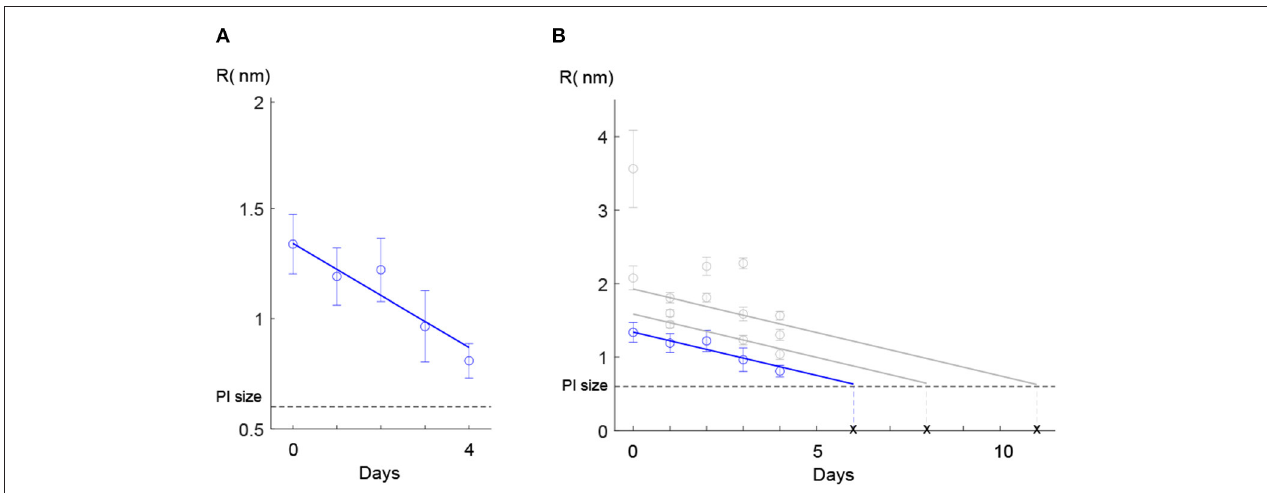
FIGURE 5 | Regression model for the pore size. (A) A weighted regression model showed that the estimated values of the pore size for the cluster with the lowest slope in the intensity curve decayed linearly over the four days. (B) The linear model was fitted to the data of the remaining clusters. Error bars in both (A,B) show the standard deviation for the estimated pore radius. The solid blue line shows the fitted linear model to the data for the least damaged cells (the cluster with the lowest slope in the intensity curve) and the solid gray lines show the predicted linear approach for resealing pores over evaluation days for the rest of the clusters. With this linear model, we could predict the time interval needed for each group to recover the membrane.